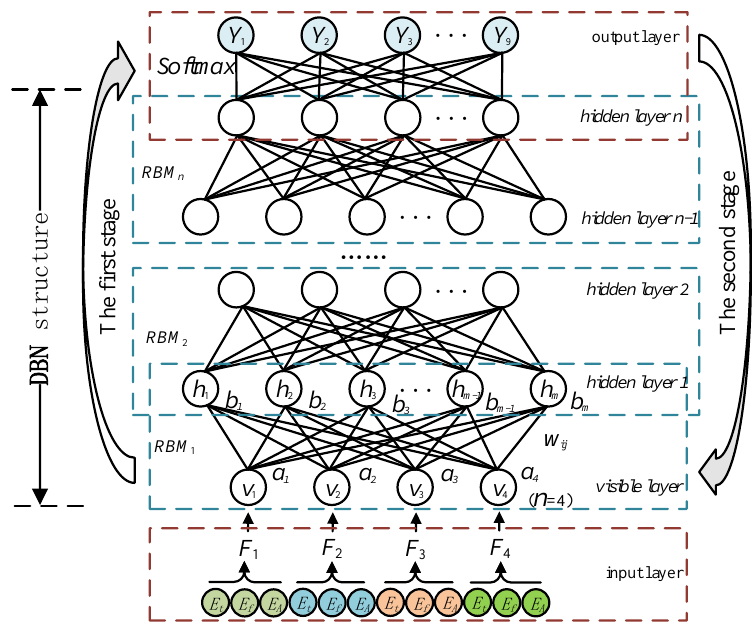
Figure 7. The DBN structure and its training process.